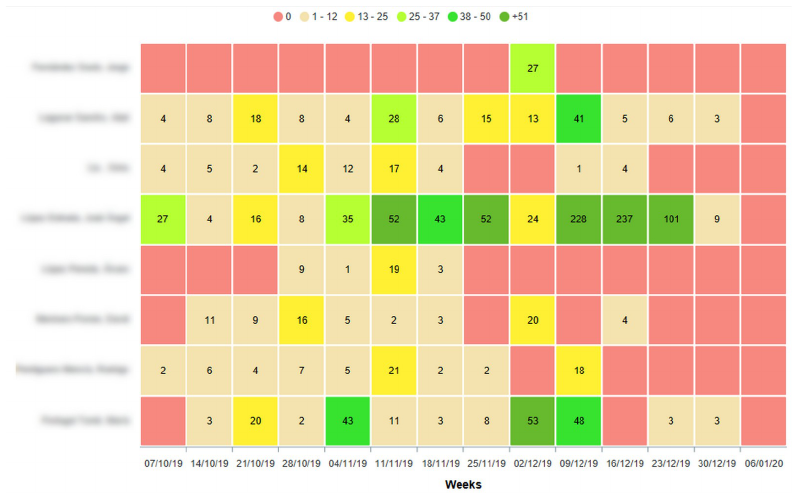
Figure 9. Section with cross-sectional